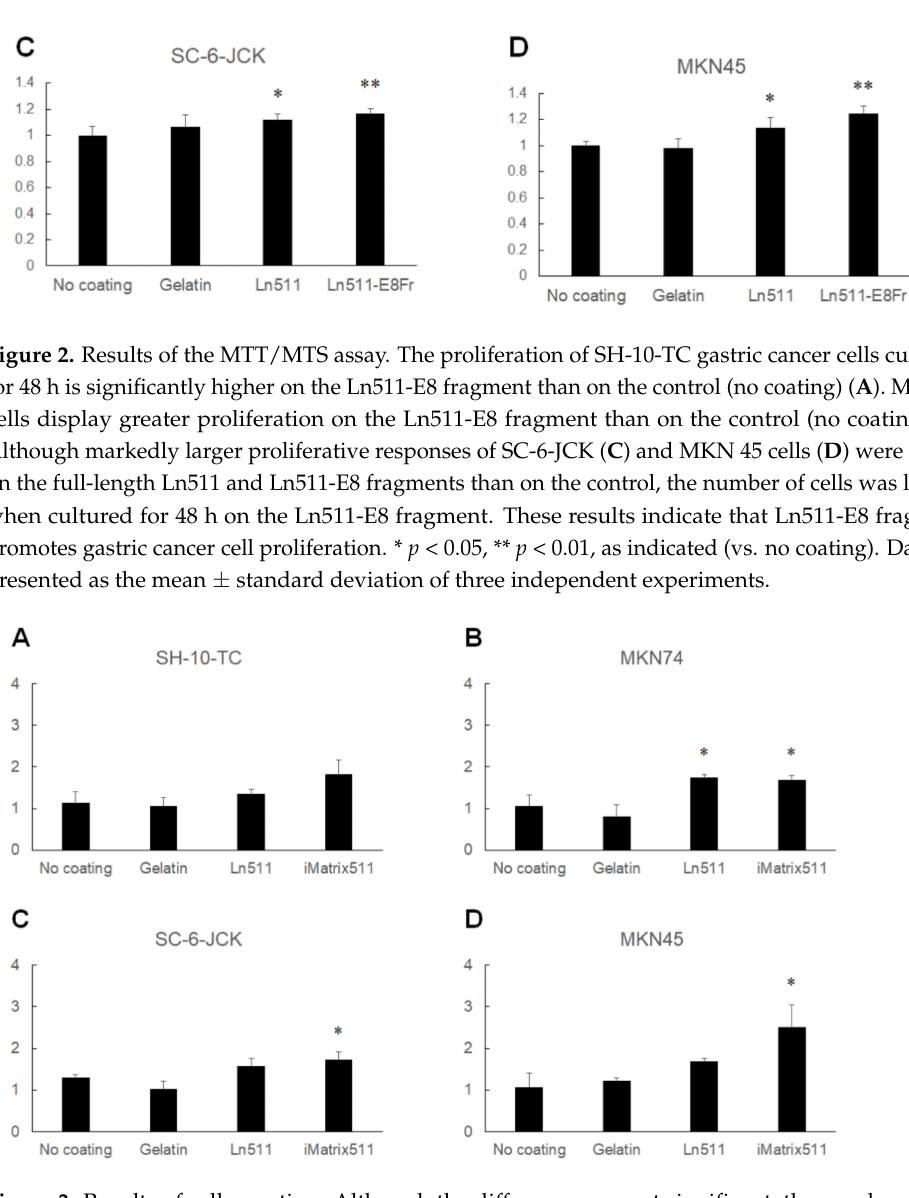
Figure 3. Results of cell counting. Although the difference was not significant, the number of SH- 10-TC gastric cancer cells cultured for 48 h was the highest on the Ln511-E8 fragment ( A ). MKN74 ( B ), SC-6-JCK ( C ), and MKN45 cells ( D ) showed significantly greater proliferation on the Ln511-E8 fragment than on the control (no coating). * p < 0.05, as indicated (vs. no coating). Data are presented as the mean ± standard deviation of three independent